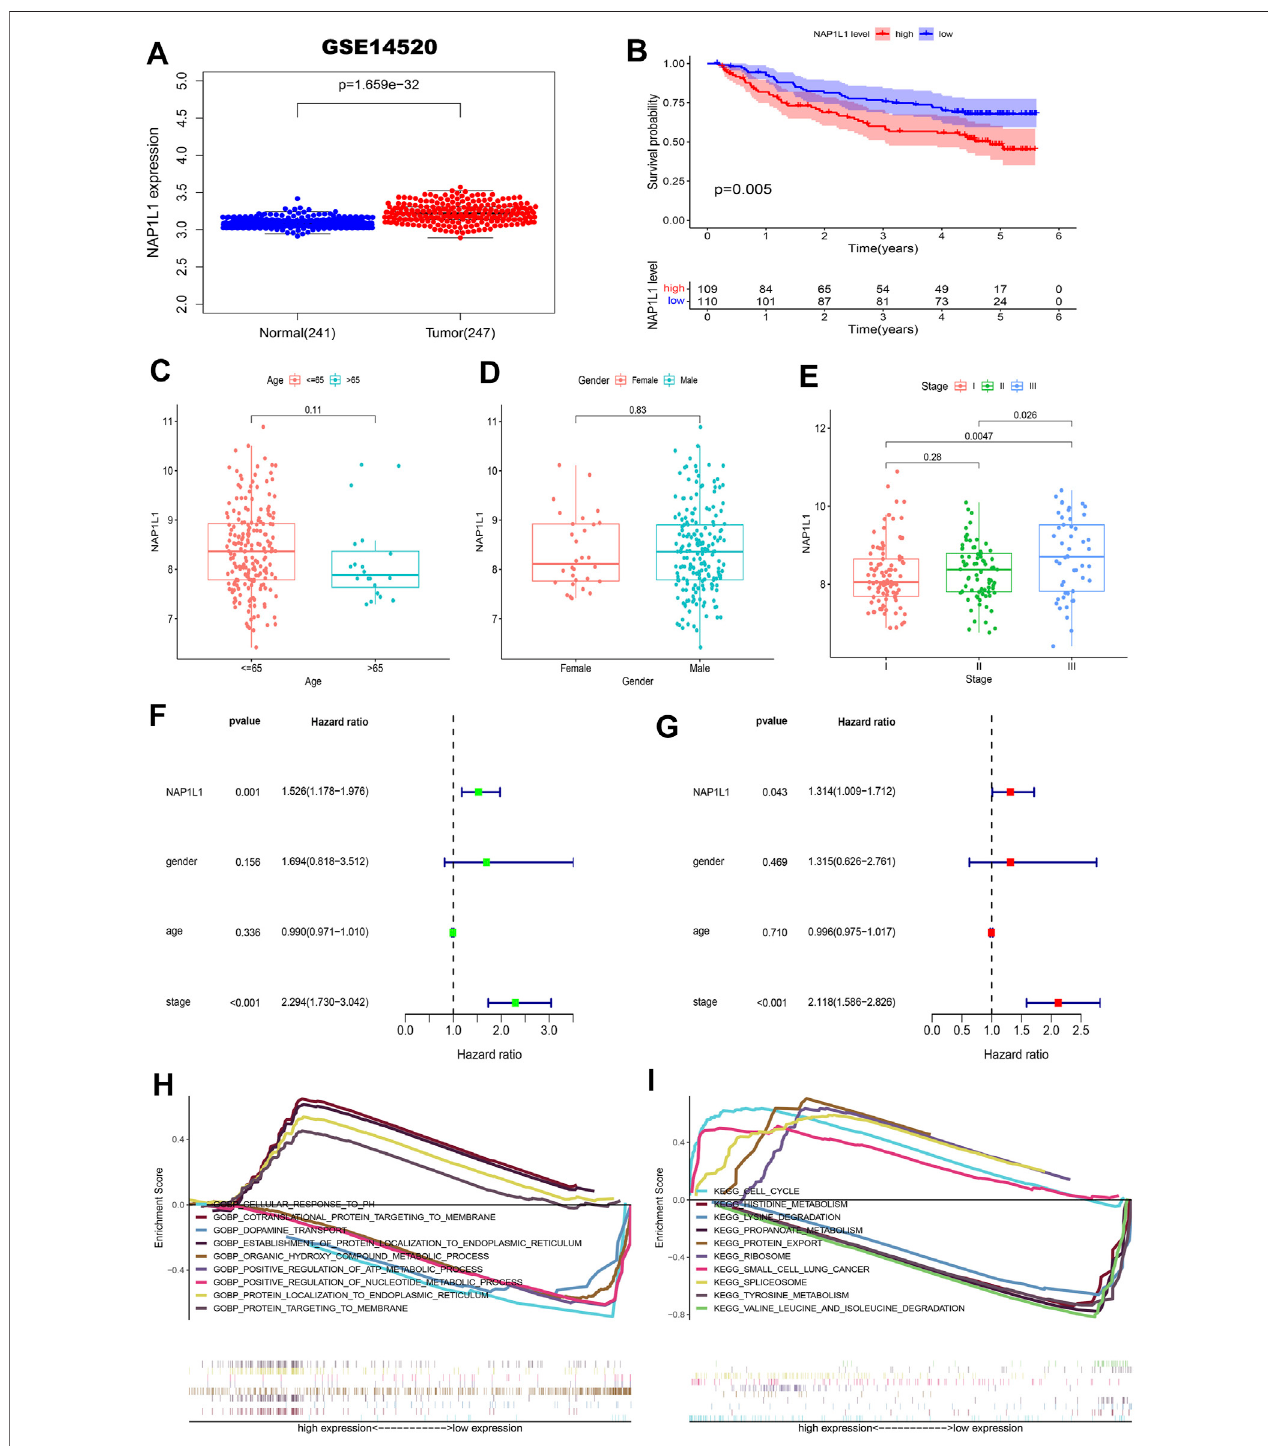
FIGURE4| Survivalanalysis, the clinicalfeatureanalysis, theunivariate/multivariate regressionanalysis,and themultiple GSEA in theGSE14520 datasets. (A) The scatterplotofthe NAP1L1 expressioninthenon-tumorandHCCspecimens. (B) ThesurvivalcurveofOSinthehighandthelow NAP1L1 expressiongroups. (C) Thebar graph in age. (D) The bar graph in gender. (E) The bar graph in stage. (F) The univariate regression analysis. (G) The multivariate regression analysis. (H) The multiple GSEA ground on the GO. (I) The multiple GSEA ground on the KEGG.